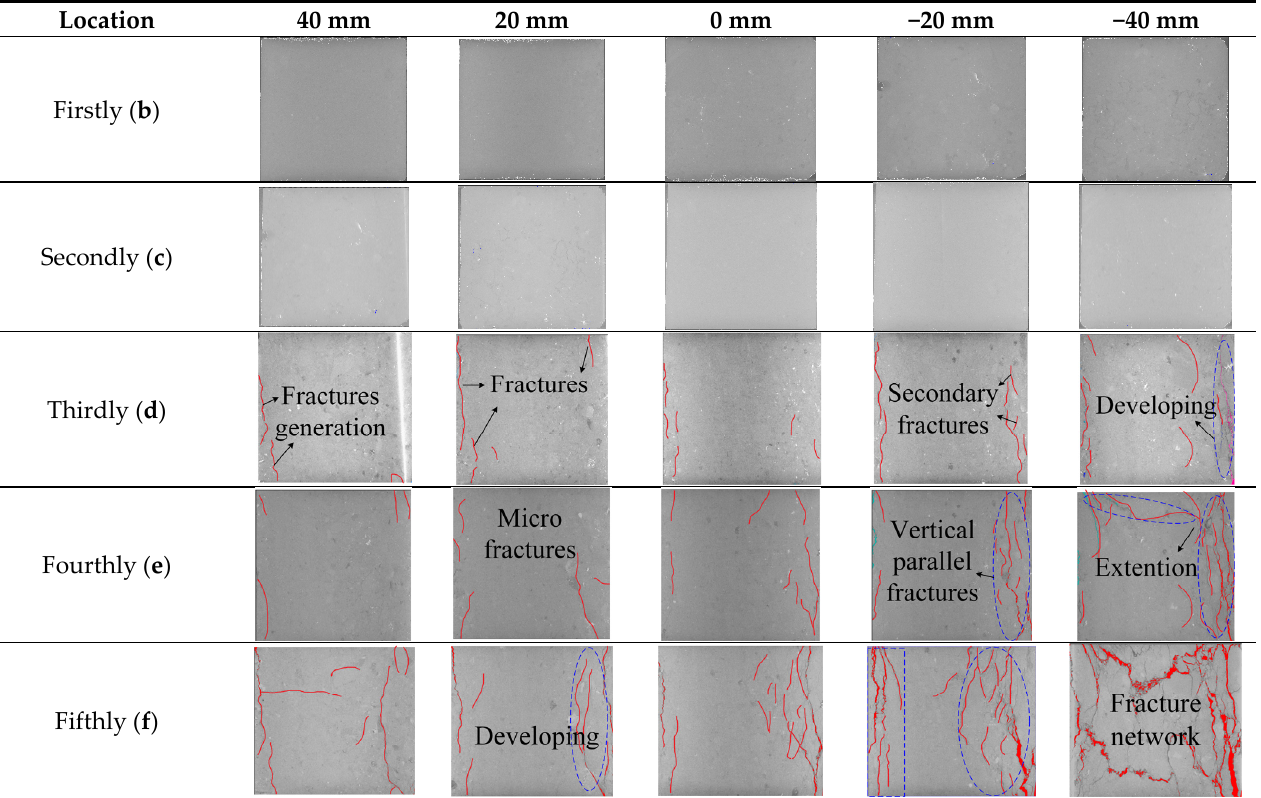
Figure 7. Slices of specimens in different positions. ( a ) Schematic diagram of section location, the specimen has a side length of 100 mm, the center of the specimen is the origin, the middle position is at 0 mm, and the sides are 50 and − 50 mm each. The distribution of the fracture extension after the specimen has been loaded and unloaded several times. ( b ) Slices of the first CT scan. ( c ) Slices of the second CT scan. ( d ) Slices of the third CT scan. ( e ) Slices of the fourth CT scan. ( f ) Slices of the fifth CT scan.